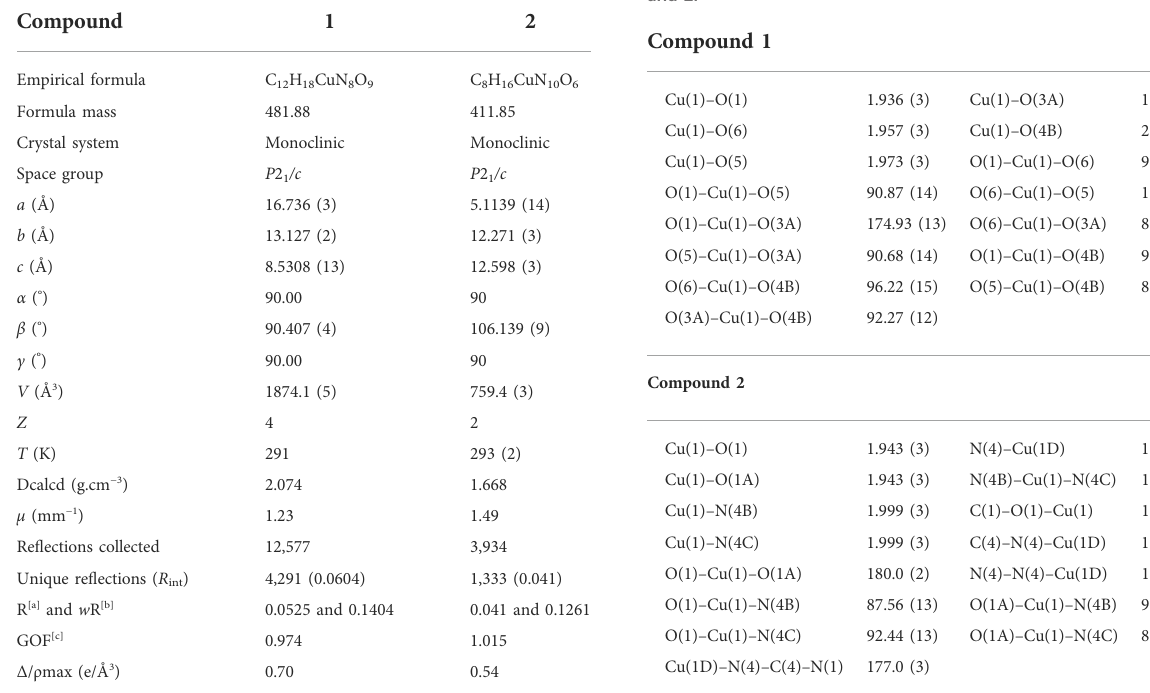
TABLE 1 Selected crystal data of compounds 1 and 2. TABLE 2 Selected bond distances (Å) and angles ( ° ) for compounds 1